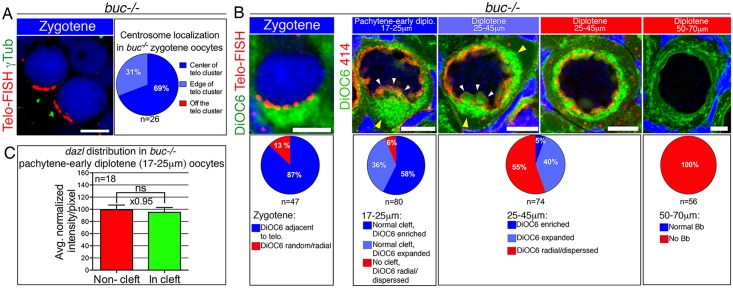
Early oocyte polarization is normal in buc-/- oocytes.(A) Telomere clustering and centrosome positioning (DAPI, blue) are normal in buc-/- oocytes (n = 5 ovaries). Pie chart: centrosome position frequencies. (B)
buc-/- ovaries display normal early polarization. Pie charts show the frequencies of each phenotype. The typical phenotype is shown (top), with colors matching the represented phenotype in the charts (n = 26 ovaries). White arrowheads, nuclear cleft; yellow arrowheads, DiOC6 enrichment. Scale bars as in Fig 2B. (C) Cleft analysis results for dazl localization in buc-/- pachytene to early diplotene oocytes. Compare with Wt in Fig 1B. Mean and SEM are plotted. ns, not significant. Data in S1 Data.